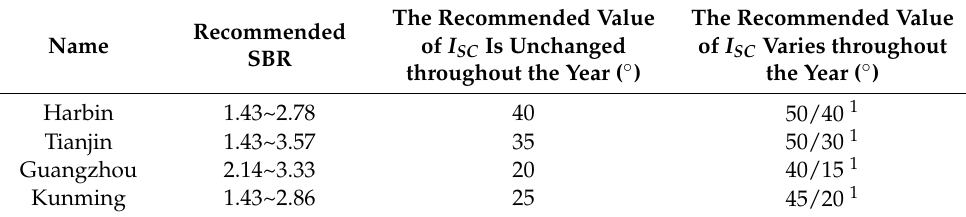
Table 5. Recommendation system configuration parameter table of other typical cities.